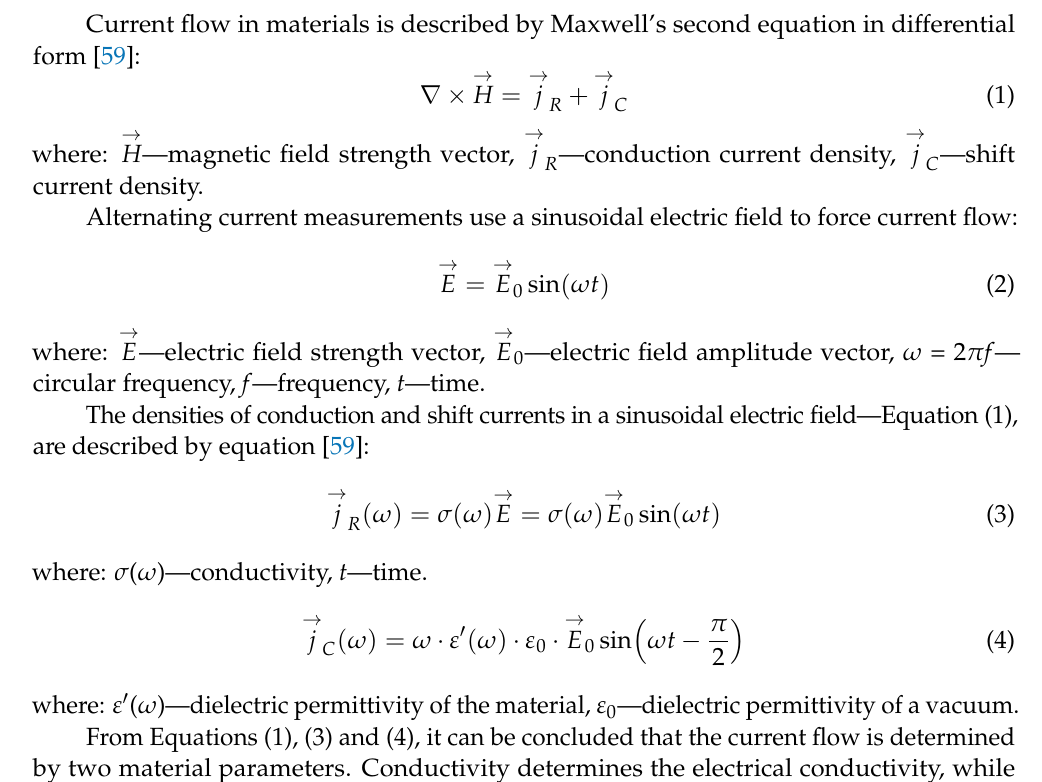
Figure 1. Cross ‐ section of Ti x Zr 1 − x C+ α‐ C y nanocomposite sample: 1—nanocomposite layer, 2—sili ‐ Figure 1. Cross-section of Ti x Zr 1 − x C+ α -C y nanocomposite sample: 1—nanocomposite layer, 2—silicon con substrate (bottom plate), 3—silver paste top plate, 4—silver paste electrode. substrate (bottom plate), 3—silver paste top plate, 4—silver paste